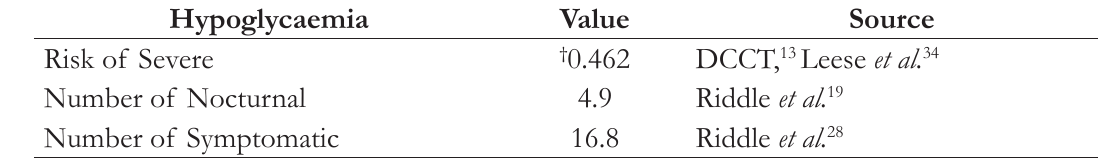
Table 3. Estimated Annual Hypoglycaemia Risks and Number of Expected Events